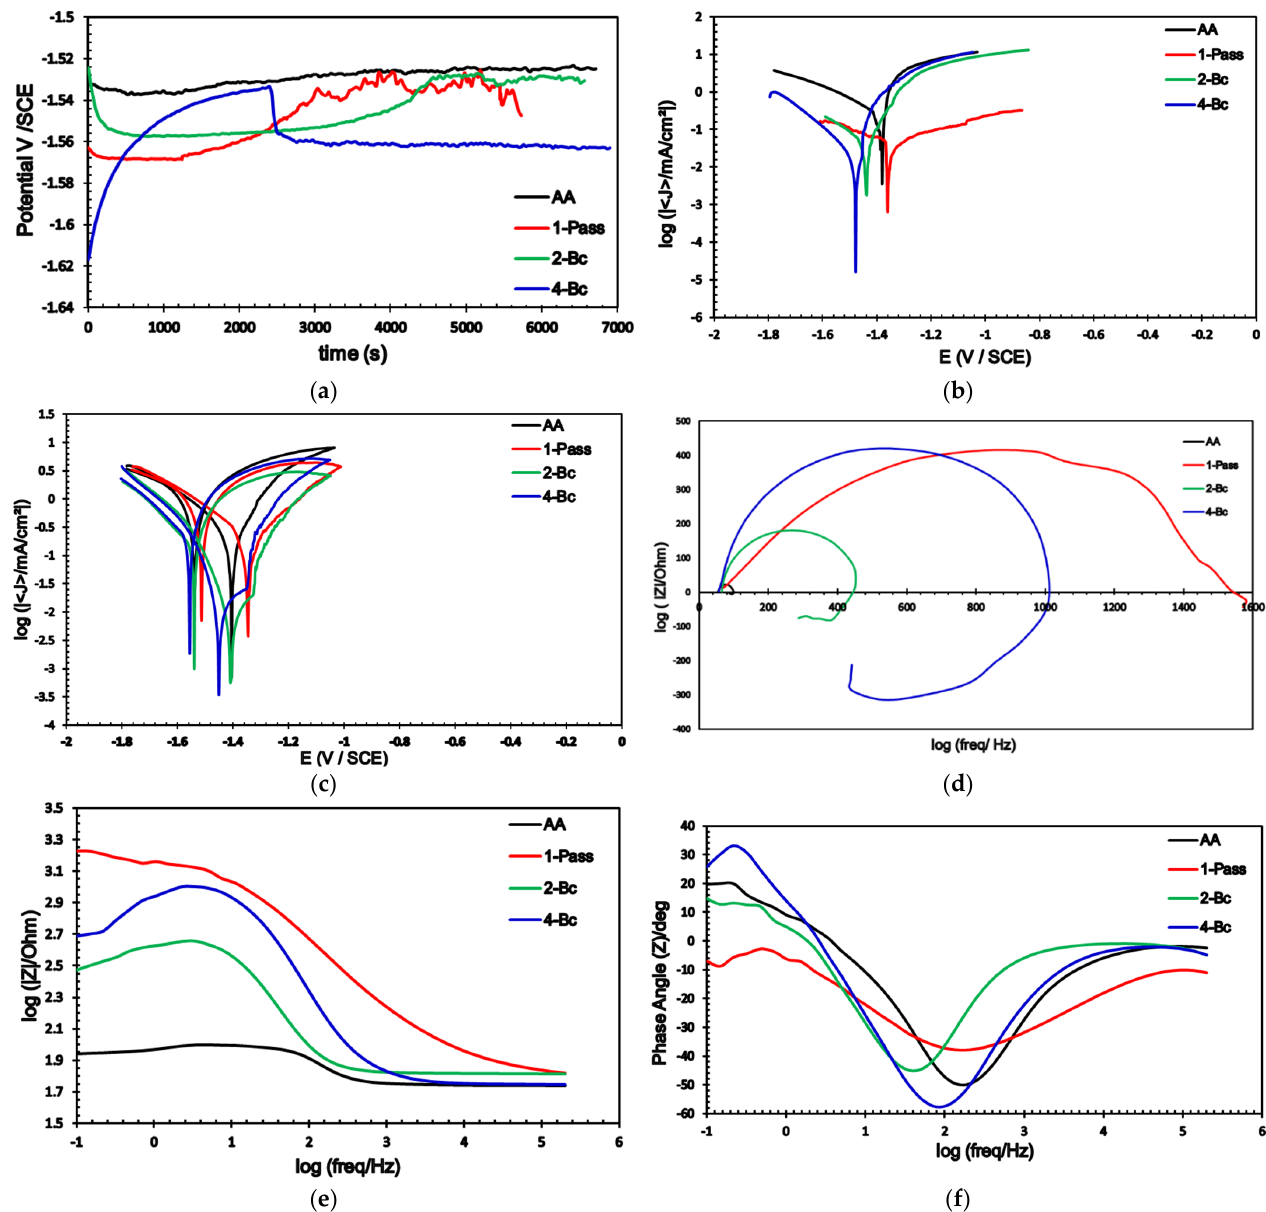
Figure 10. Corrosion measurements ( a ) OCP curves, ( b ) potentiodynamic polarization curves, ( c ) cyclic potentiodynamic polarization, ( d ) Nyquist plot, ( e ) Bode plot, and ( f ) Bode plots’ phase angle of ZK30 alloy using ringer lactate solution.